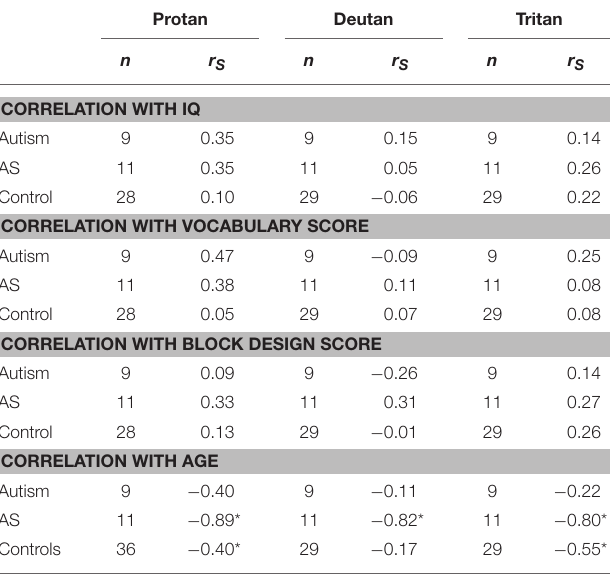
TABLE 5 | Spearman correlation coefficients between color vision measurements and IQs, Vocabulary and Block Design scores and ages. Protan Deutan